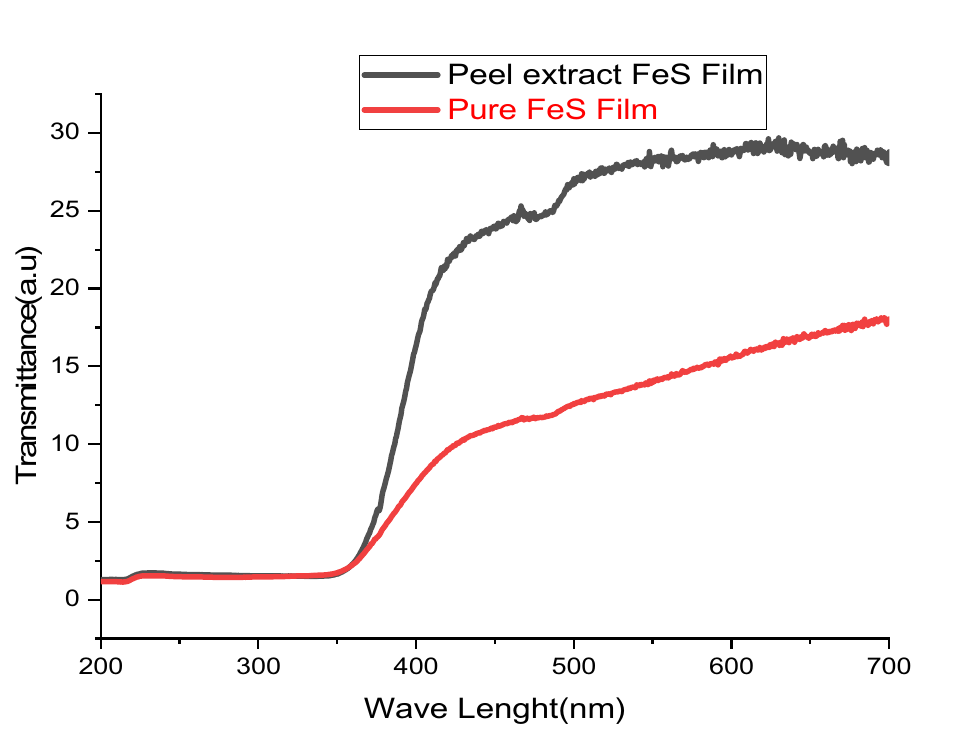
Figure 6. The transmittance of Iron sulphide thin films deposited as nanocrystalline FeS from banana leaf extraction and pure FeS/chemically prepared thin